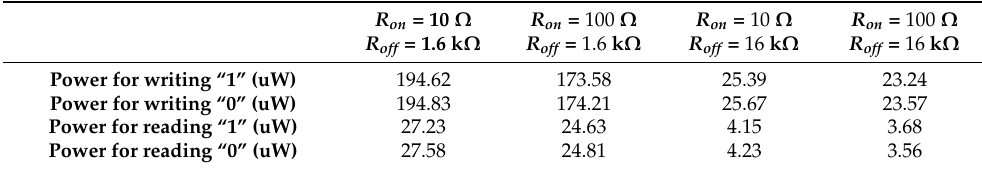
Table 5. Reading and writing power consumption at different resistance